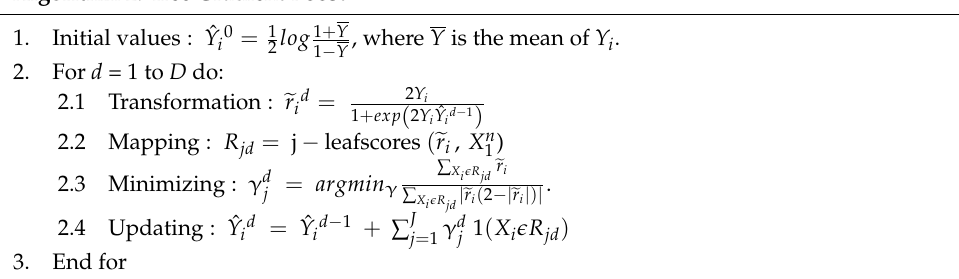
Algorithm 2. Tree Gradient